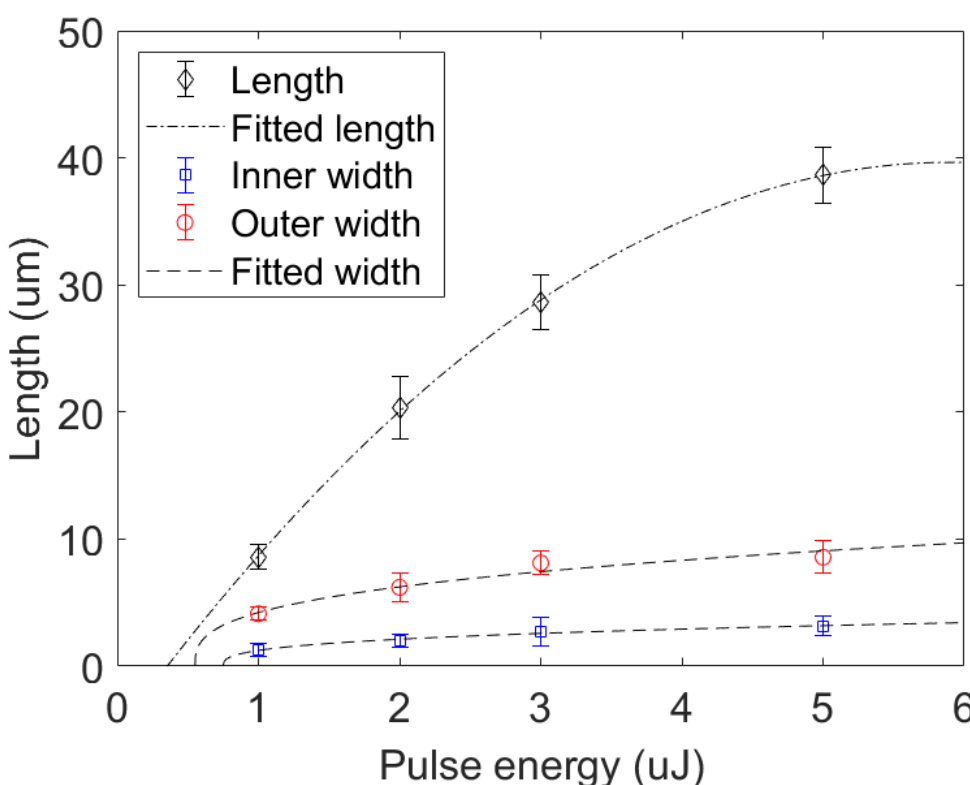
Figure 3. Damage sizes vs. input pulse energy. The length of the damage track vs. the input pulse energy are indicated by the diamond mark. The dotted dashed line is a polynomial fit of the damage length with two degree of freedom. The inner and outer width of the damage track vs. pulse energy are indicated by square and circle mark, respectively. The dashed line is fitted based on Equations (4) and